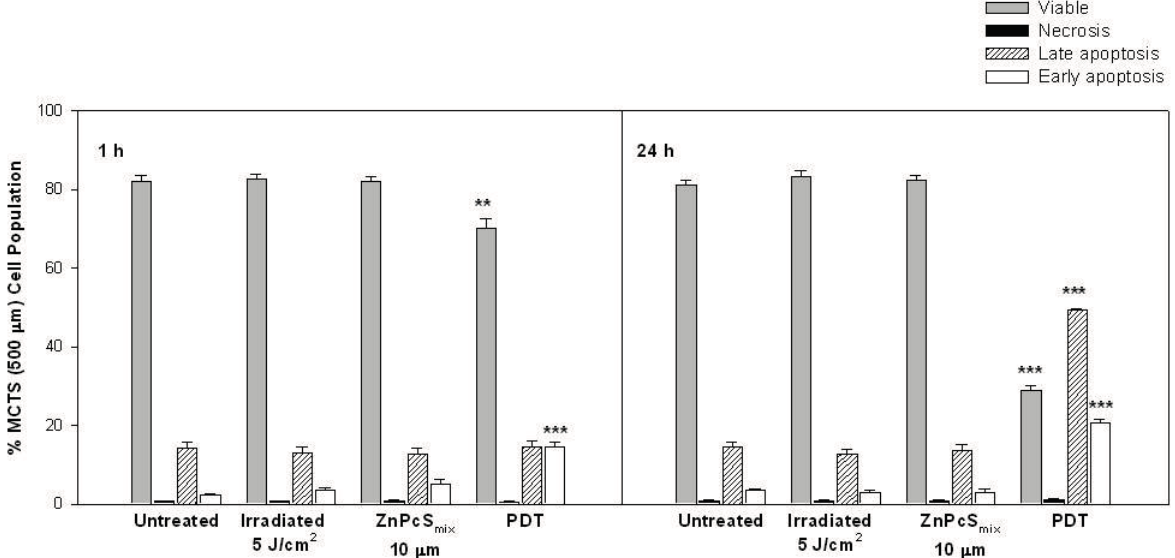
Figure 3. Evaluation of different stages of cell death as determined by flow cytometric analysis in multicellular tumour spheroids (MCTSs) with a size of 500 µm ( n = 4). Photoactivated ZnPcS mix at 10 µM and 5 J/cm 2 resulted in a significant decrease in viable cells and an increased percentage population of early apoptotic cells 1 h post